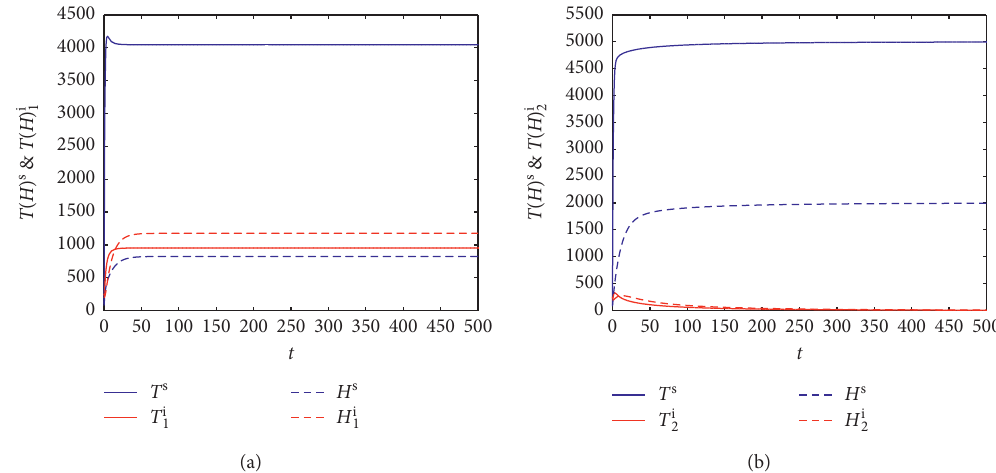
Figure 2: Solutions of submodels (33) and (37). The numbers of susceptible and infectious individuals are represented by blue and red curves, respectively, where solid lines denote the number of susceptible or infectious ticks, and dotted lines denote the number of susceptible � 1 . 025 > 1 for this parameter choice, which indicates that disease 1 or infectious hosts. (a) Subsystem (33) stabilizes at equilibrium E 1 as R 1 1 can be endemic in tick and host populations; (b) susceptible ticks and hosts eventually approach and stabilize at 4990 and 1985, respectively, � 0 . 943 < 1, which implies that disease 2 cannot spread in the tick-host population. but infected ticks and hosts die out as R 2